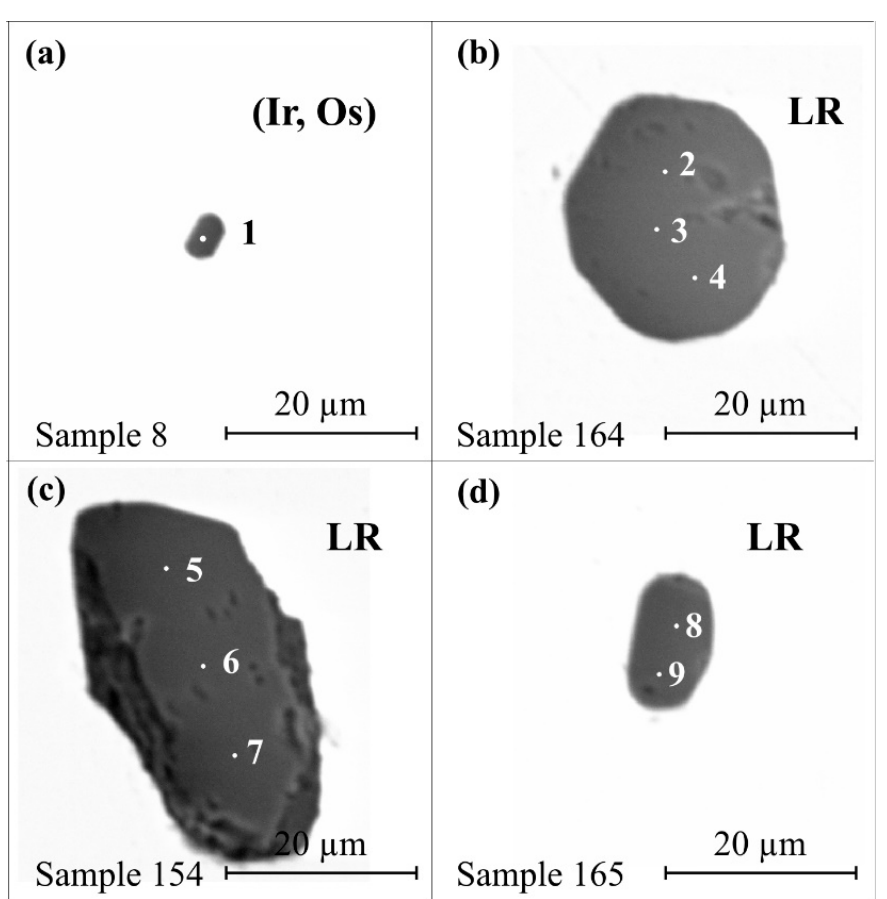
Figure 4. Back-scattered electron images of forsterite inclusions in: ( a ) osmian iridium (Os,Ir), ( b – d ) laurite (LR). Numbers 1–9 denote areas of electron microprobe analyses corresponding to the same numbers in Table 3.